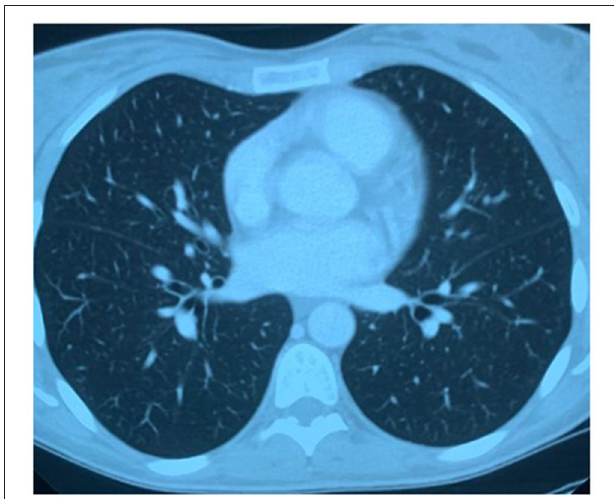
FIGURE 2 | Pulmonary computed-tomographic (CT) performed on February 13th, 2020: complete restoration of the physiological transparency of the lung fields without residual consolidation thickenings and thin bilateral basal fibrotic